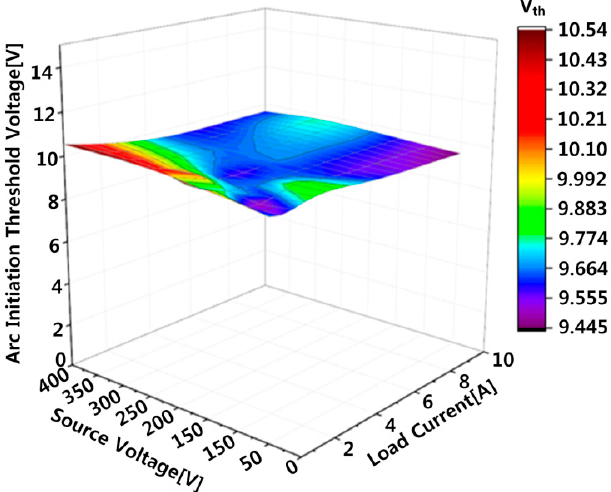
Figure 8. Characteristics of arc initiation threshold voltage as source voltage and load current.